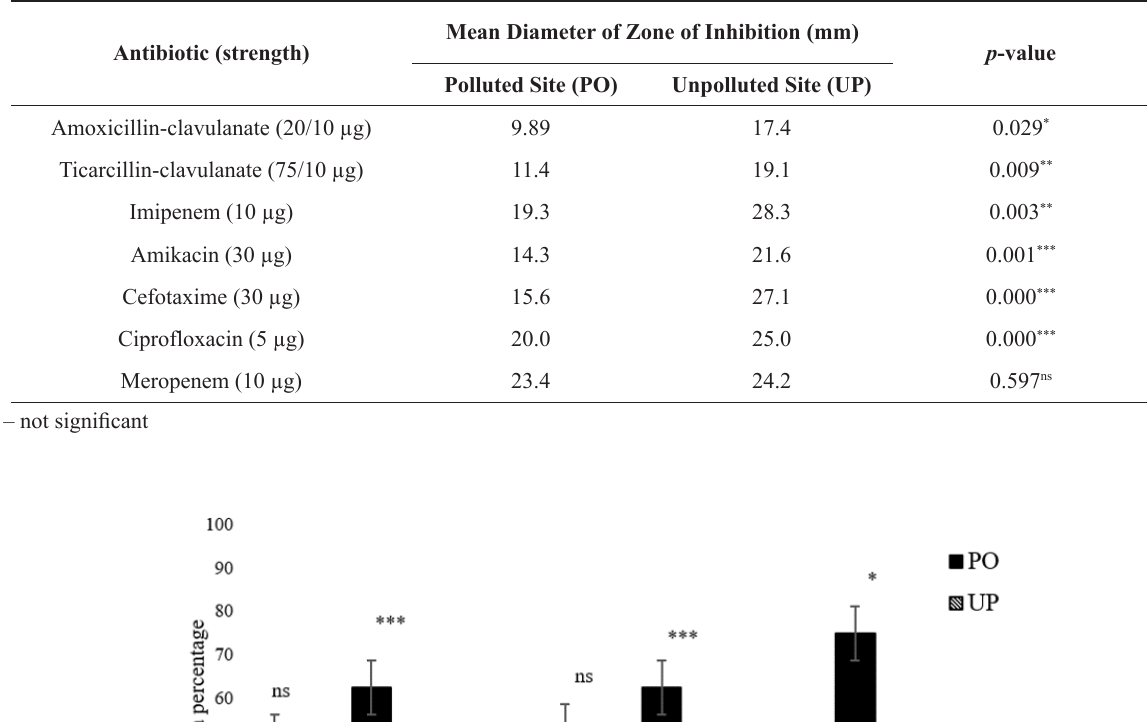
Table 1 : Means of diameters of inhibition zones obtained from disk diffusion method for bacterial isolates from polluted (PO) and unpolluted (UP) soils with seven antibiotics. The level of significance; * p ≤ 0.05; ** p ≤ 0.01; *** p ≤ 0.001 at significance level 5%.